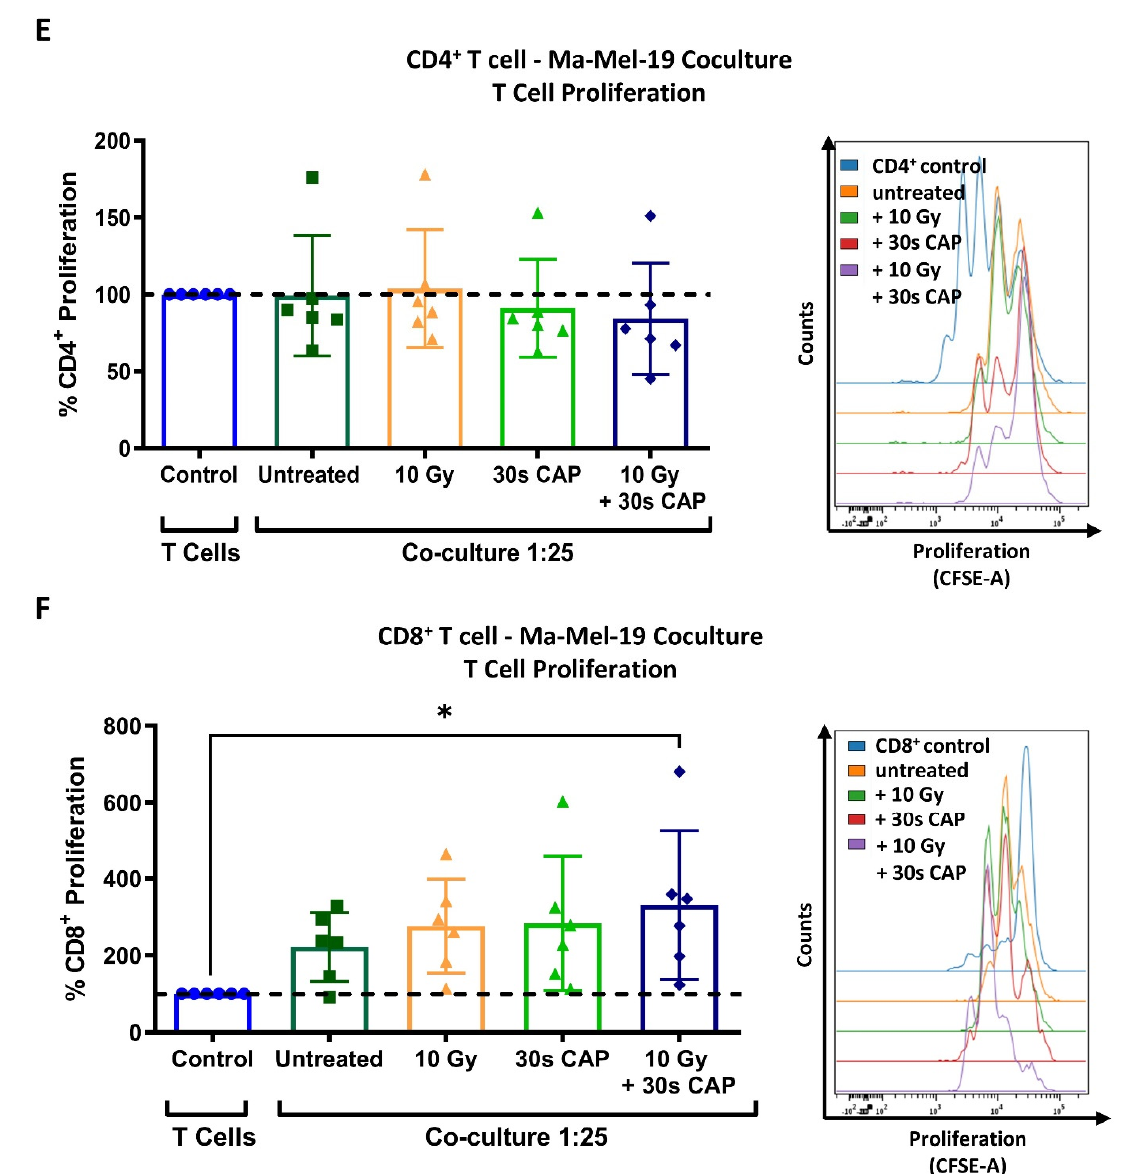
Figure 2. CD4 + and CD8 + T cells exhibit a higher sensitivity to CAP treatment than melanoma cells. ( A , B ) CFSE prelabeled stimulated CD3 + T cells were treated with varying amounts of CAP (0 s, 5 s, 30 s, and 60 s). After 3 days, cells were analyzed via flow cytometry; ( A ) cells were stained for viability. Bar diagram shows the average percentage of live cells measured ± SD, normalized to the untreated control of the same donor. Data consist of the pooled results of 4 independent experiments ( n = 12 donors); ( B ) bar diagram shows the average percentage of proliferating CD3 + T cells, ± SD normalized to the untreated control of the same donor. Data consist of the pooled results of 4 independent experiments ( n = 12 donors); statistical significance was calculated by performing ordinary one-way ANOVA tests corrected for multiple comparisons with Dunnett tests; ( C , D ) stimulated CD3 + T cells treated with varying amounts of CAP (0 s, 5 s, 30 s, 60 s). After 3 days, cells were analyzed in flow cytometry; ( C ) bar diagram shows the average percentage of CD3 + CD4 + and CD3 + CD8 + T cells in CD3 + T cells ± SD, normalized to the untreated control of the same donor. Data consist of the pooled results of 4 independent experiments ( n = 12 donors); ( D ) CD3 + CD4 + and CD3 + CD8 + T cells were stained for viability. Bar diagram shows the average percentage of live cells measured ± SD, normalized to the untreated control of the same donor. Data consist of the pooled results of 4 independent experiments ( n = 12 donors); ( E , F ) CFSE prelabeled stimulated CD4 + and CD8